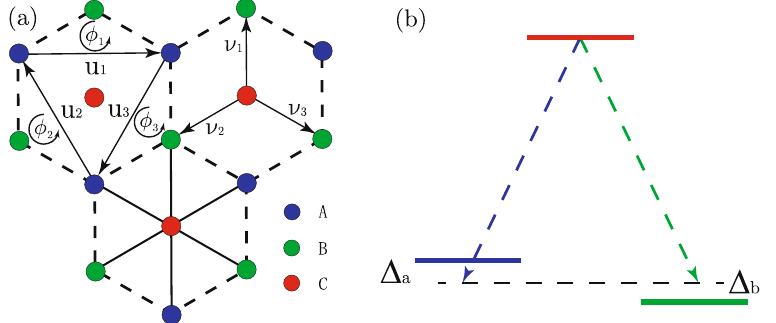
Figure 1. ( a ) Honeycomb-like lattice with NN vectors ν i and NNN vectors u i , pierced by effective magnetic flux i p u /2 ( 1, 2, 3) i i φ = ⋅ = . Atoms of three different states are trapped on inequivalent sites. ( b ) State A and B are coupled with state C by two laser beams, with detuning Δ a and Δ b